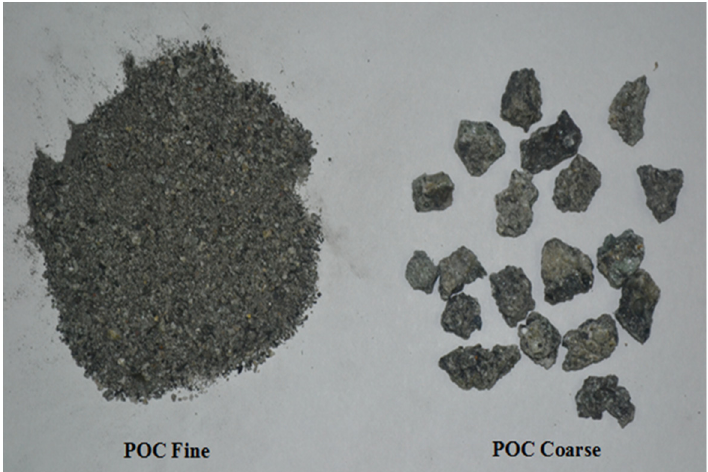
Figure 2. POC Fine and POC Coarse.